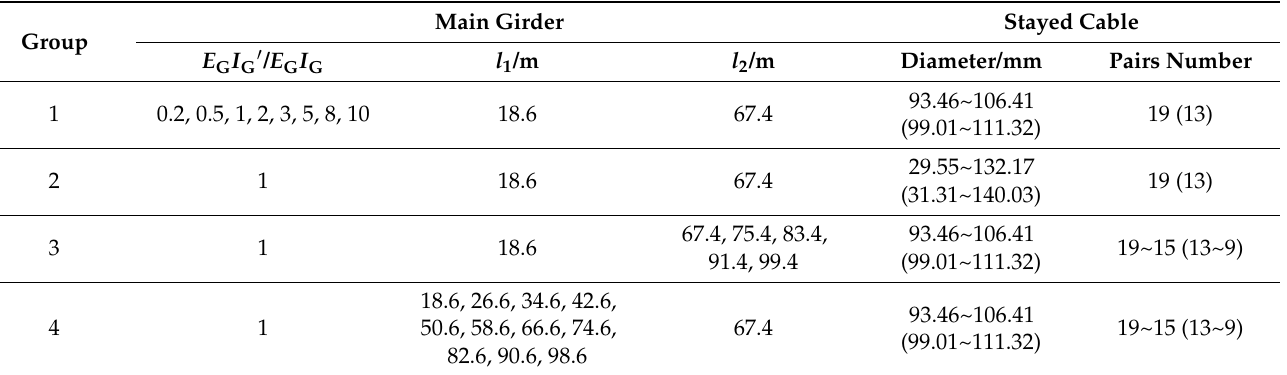
Table 2. Parameter value